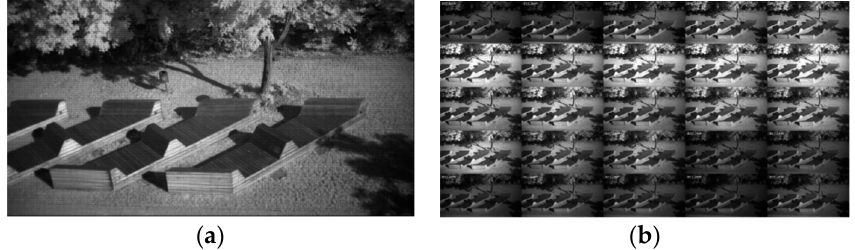
Figure 2. ( a ) Hyperspectral input frame and ( b ) planar hyperspectral cube after demosaicing. Taken from